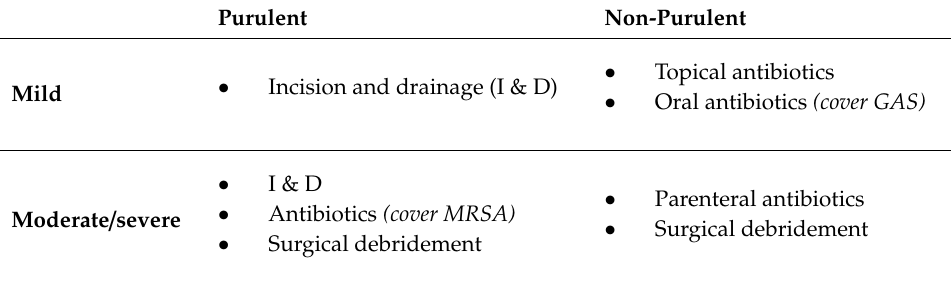
Table 2. Simplified management of SSTIs (adapted from